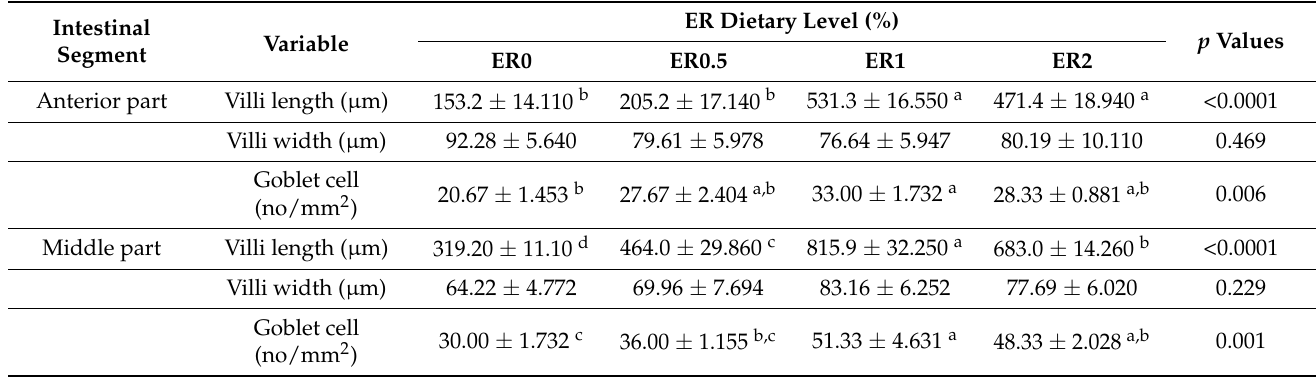
Table 5. Analysis of the intestinal morphology of Red tilapia exposed to varying levels of ER in their